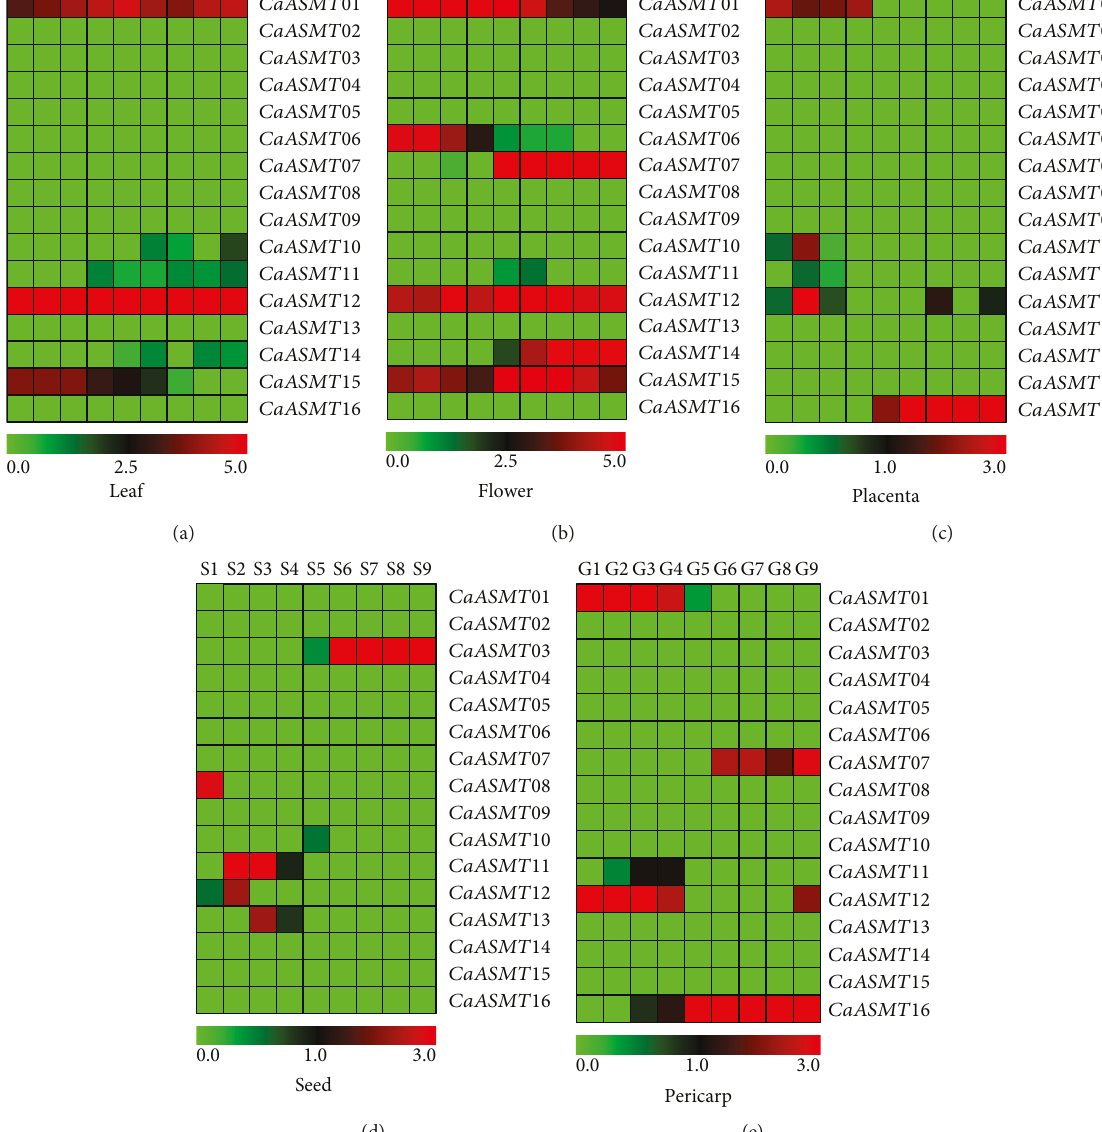
Figure 4: Heat map representation of organ-speci fi c CaASMT gene expression pro fi les in di ff erent tissues of pepper, including leaf (a), fl ower (b), pericarp (c), seed (d), and placenta (e). The data were normalized based on the mean expression value of each gene in all identi fi ed tissues. Then, the log2-transformed RPKM values were used to obtain heat maps using the software MeV 4.9.0. Red and green boxes indicate high and low expression levels of the CaASMT genes, respectively. Leaf samples were collected at 5, 10, 15, 20, 25, 30, 40, 50, and 60 days after emergence (DAE) and were named L1 to L9, respectively. Floral buds were collected at 0.25 cm, 0.35 cm, 0.5cm, 0.7cm, 0.8cm, 1 cm, 1.2cm, 1.45cm, and 1.7cm and were named F1 to F9, respectively. Placenta, seed, and pericarp grown from the tagged fl owers were collected at 20, 25, 30, 35, 40, 45, 50, 55, and 60 days after fl owering (DAF) and were named T1 to T9, S1 to S9, and G1 to G9,